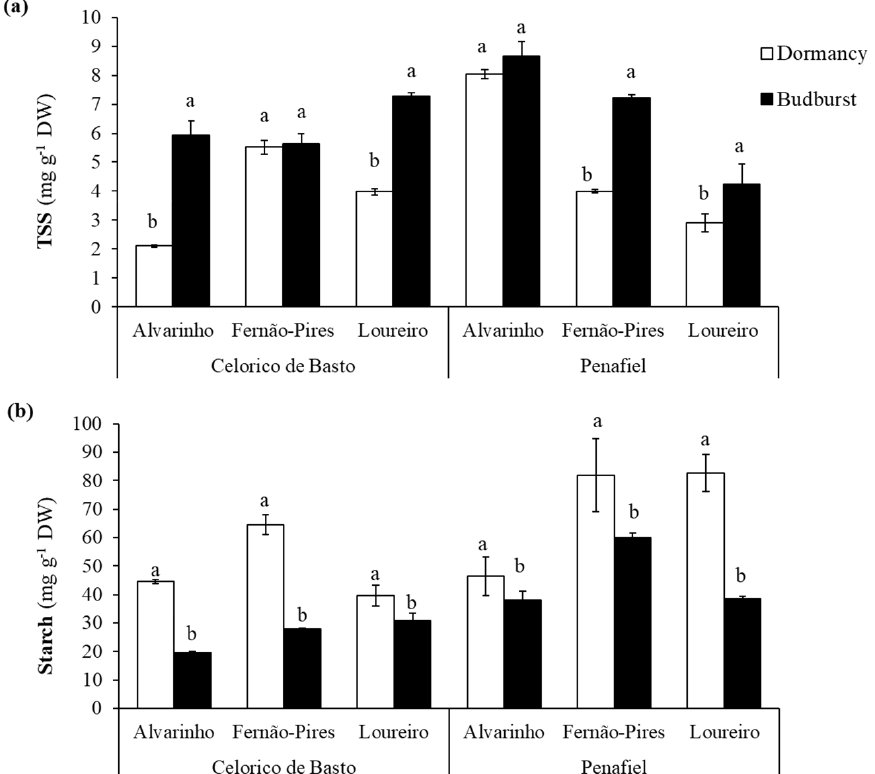
Figure 4. Total soluble sugar (TSS) ( a ) and starch content ( b ) at dormancy and budburst for Alvarinho, Fernão-Pires, and Loureiro buds from Celorico de Basto and Penafiel sites. The columns represent the mean values and the bars the respective standard error of three replicates. Different letters indicate significant differences between phenological stages ( p < 0.05).